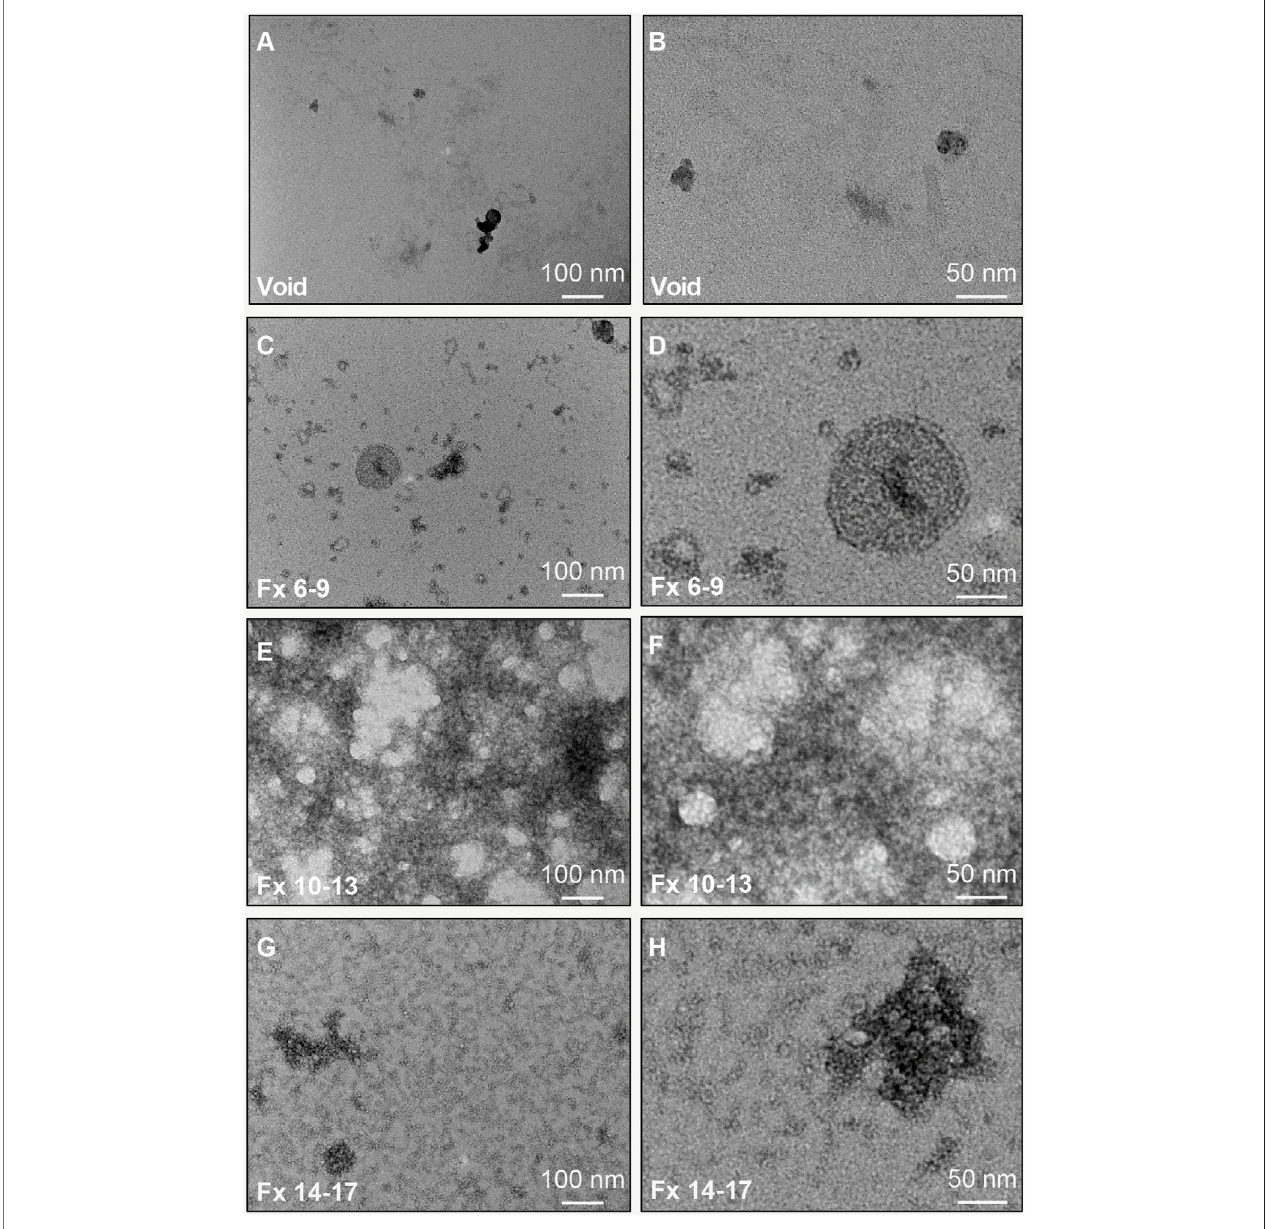
FIGURE 4 | TEM characterization of CSF EVs isolated by SEC. Representative TEM images of pools of SEC fractions (Fxs): 1 – 5 ( (A,B) ; column void volume), 6 – 9 (C,D) , 10 – 13 (E,F) , and 14 – 17 (G,H) . Note: Fxs 6 – 9 show membrane bound vesicles at a size range of ~30 – 100 nm, with depletion of proteins and lipoproteins, which arepresentin Fxs 10 – 13 and 14 – 17.Panels (A,C,E,G) arewide fi eld ofview (scale bars =100 nm) and panels (B,D,F,H) are close upviews(scale bars =50 nm).